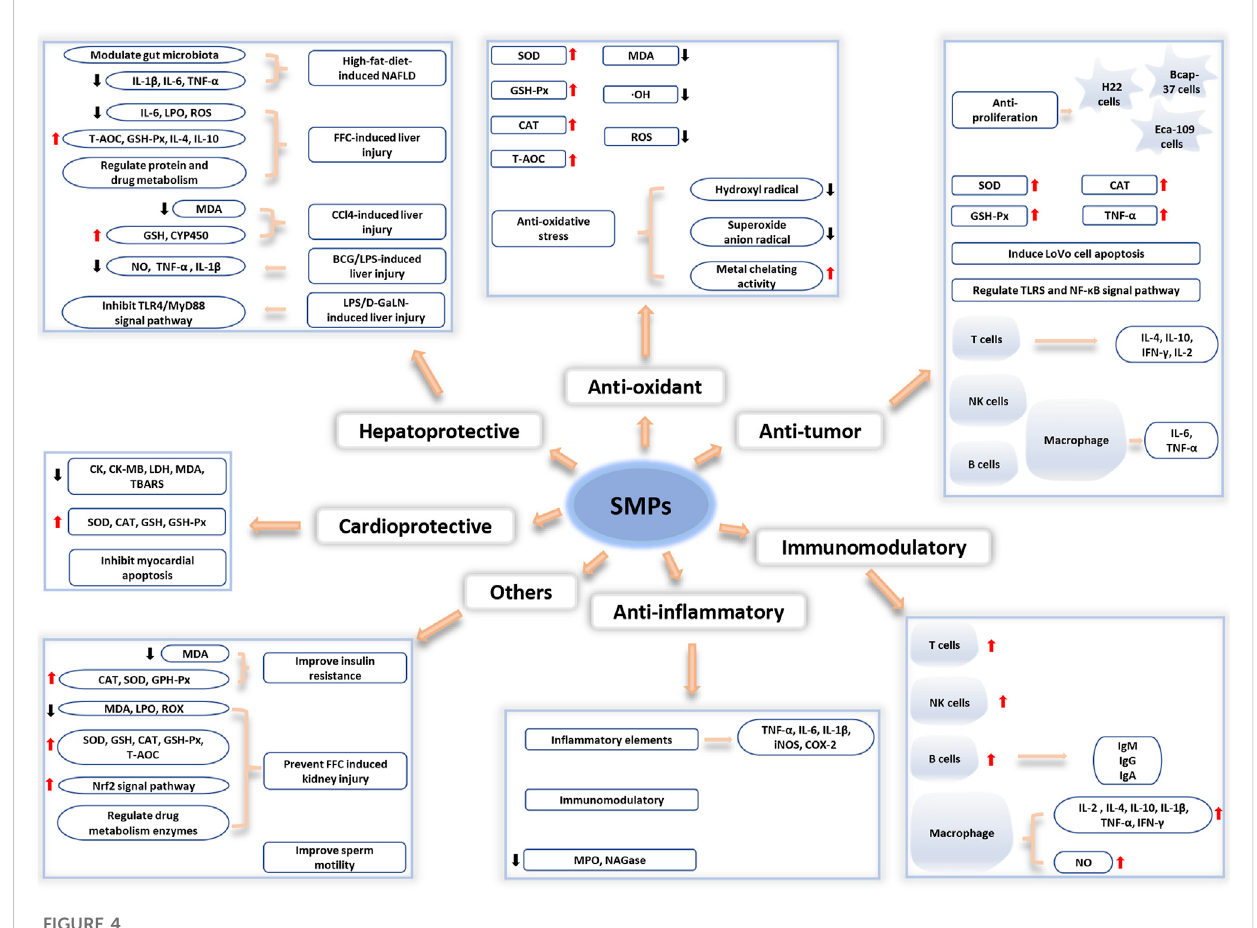
The biological activities and molecular mechanisms of